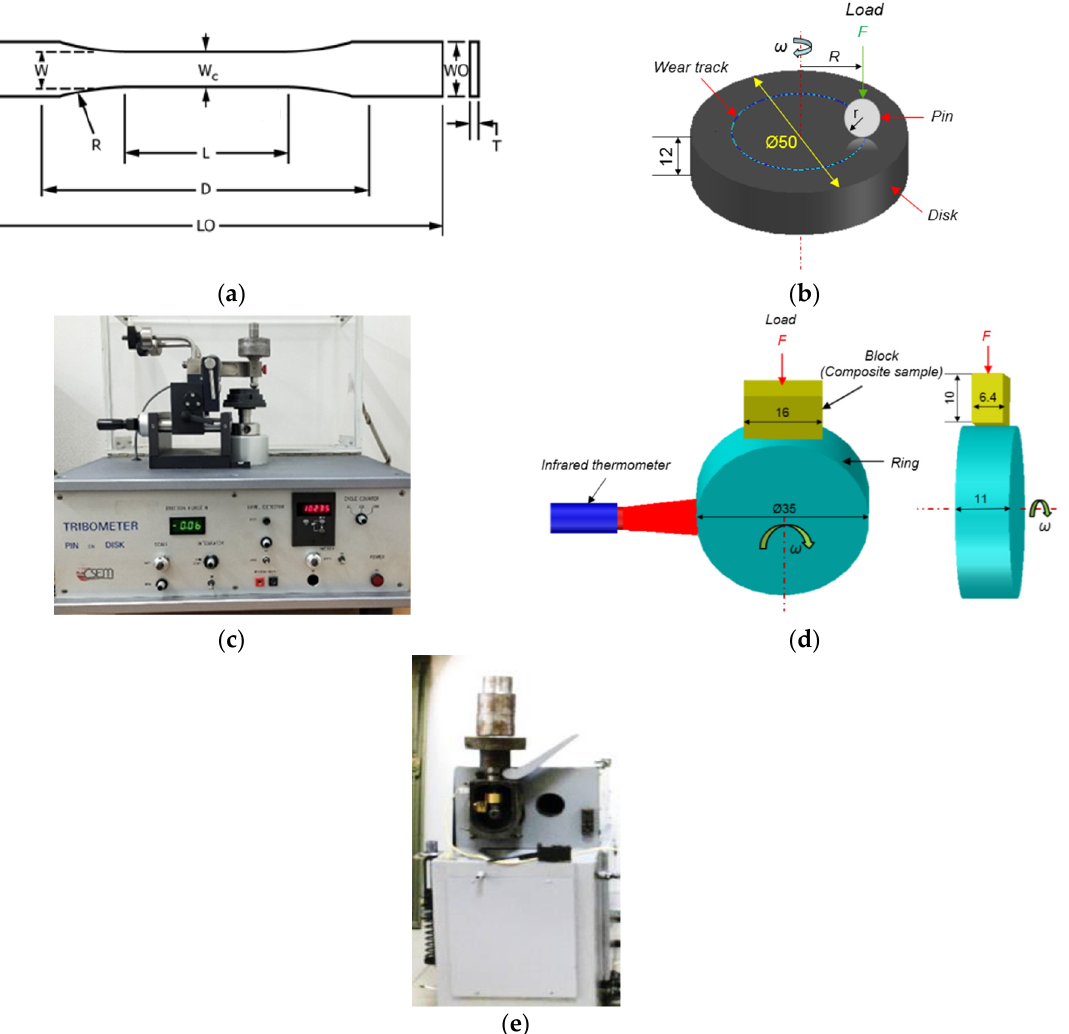
Figure 1. Dimension of a dog-bone specimen ( a ) and the schematic representation of the tribological testing schemes and equipment: “pin-on-disk” ( b ) and CSEM CH2000 tribometer ( c ); “block-on-ring” ( d ) and 2070 SMT-1 friction testing machine ( e ).